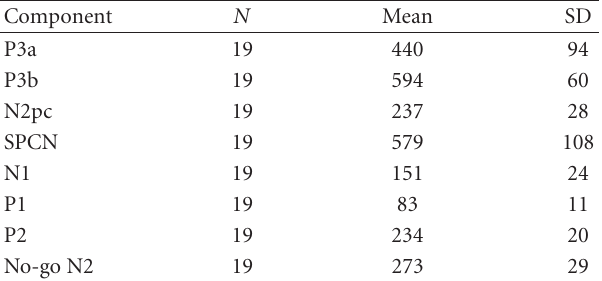
Table 6: Mean latency (ms) for components of